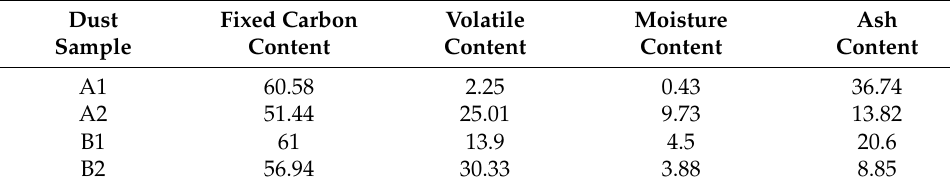
Figure 2. Four kinds of coal dust particle size distribution. Table 2. Proximate analysis of four kinds of coal dust.